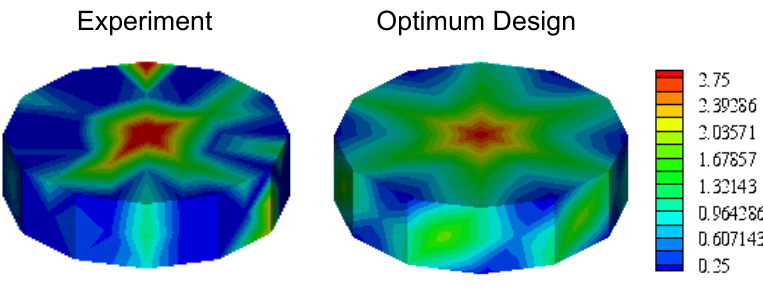
Figure 5. Comparison of Ti-7Al microstructures at 20% compressive strain.